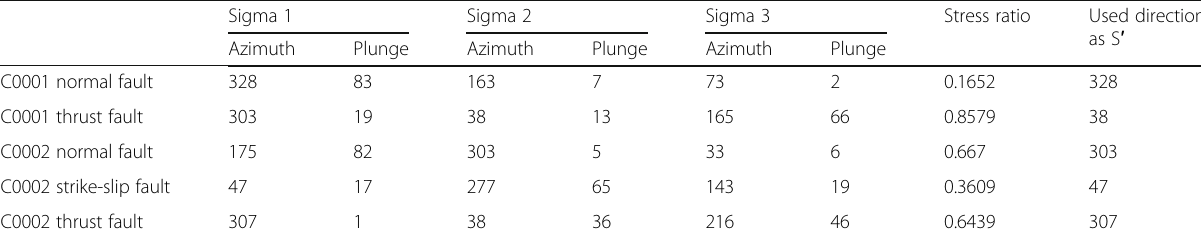
Table 2 Stress axis orientation and stress ratio estimated from core-scale fault inversion and directions of